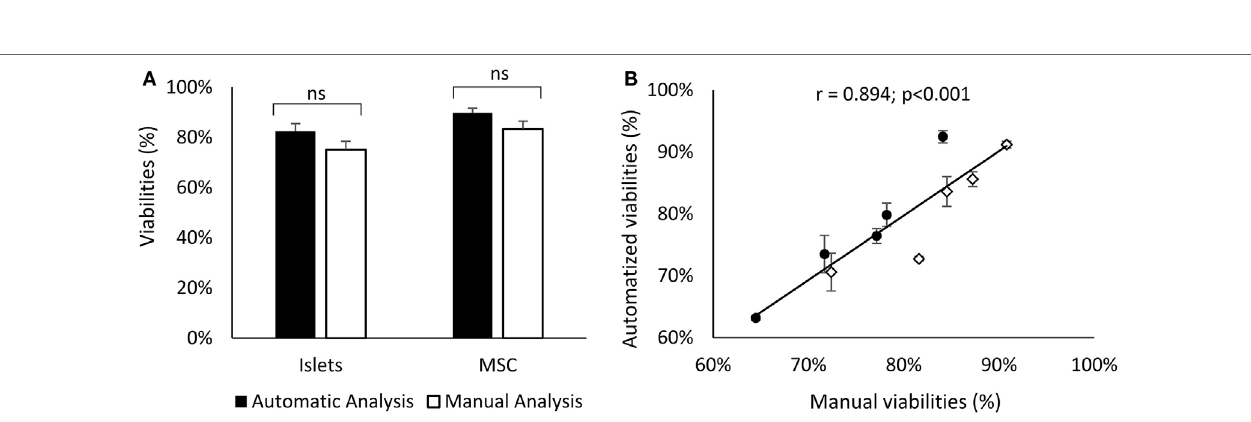
FIgURe 3 | Comparison of the islets (black) and MSCs (white) viability obtained manually or with the software (A) . Correlation between these two methods for islets (dots) and MSCs (diamonds) cells (B) . Errors bars of panel (B) correspond to variability of viabilities manually obtained by different experimenters. Results represent the mean ± SD; n = 5. Abbreviation: MSCs: mesenchymal stem cells.